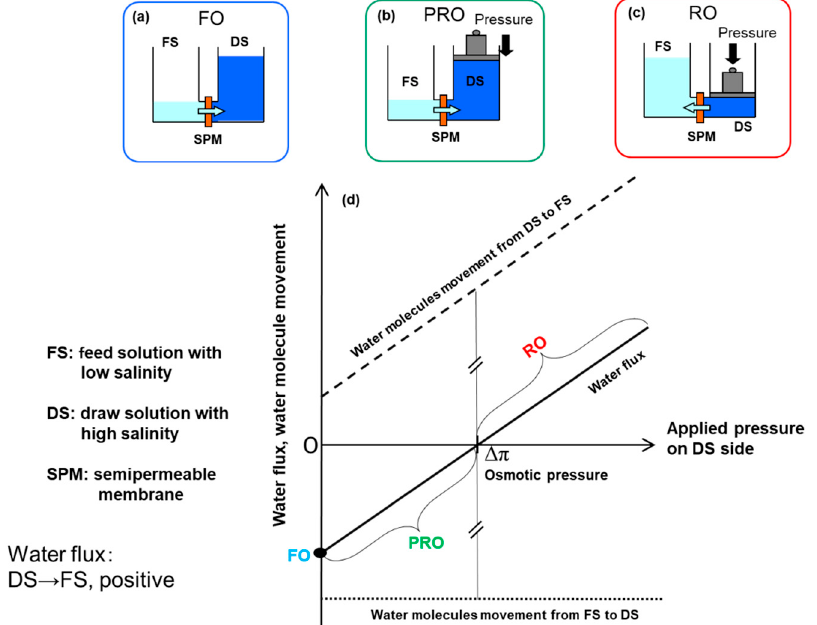
Figure 1. Water flux and water molecule movement in a dialysis system consisting of semi-permeable membrane (SPM), feed solution (FS), and draw solution (DS), to explain principle of forward osmosis (FO), pressure-retarded osmosis PRO, and reverse osmosis (RO).